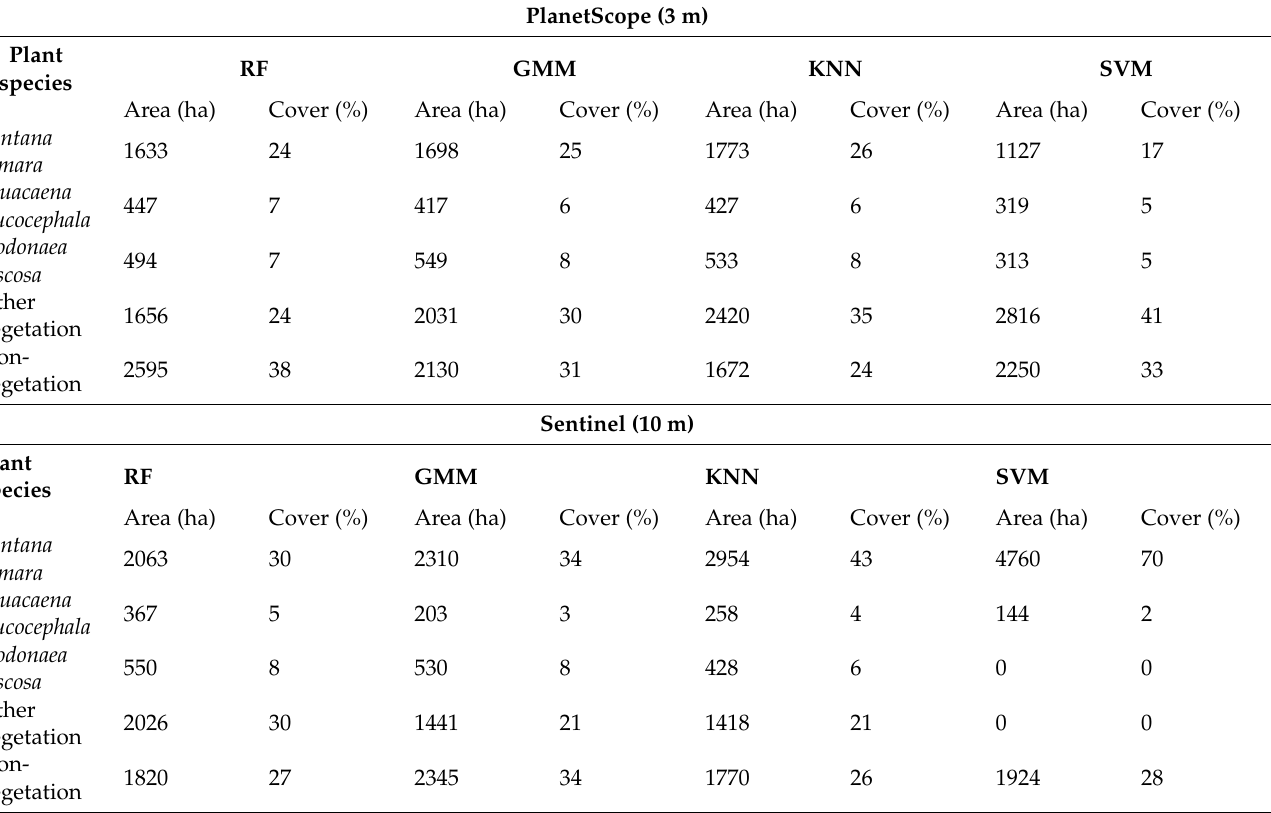
Table A1. Area (ha) and percentage cover (%) of different classes using PlanetScope (3 m) and Sentinel-2 satellite